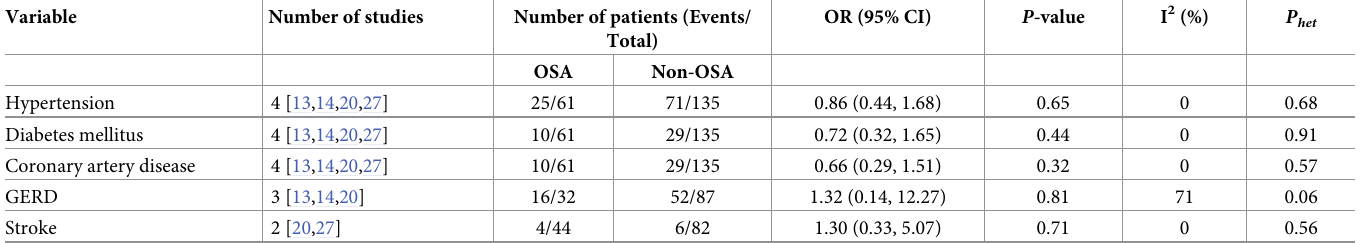
Table 4. Comparison of comorbidities between DPLD patients with and without OSA.